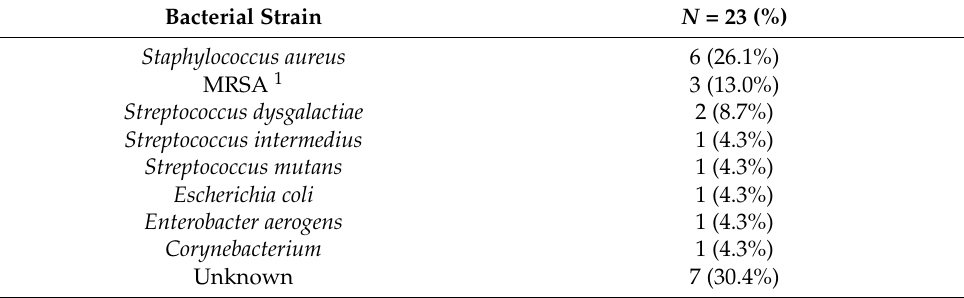
Table 2. Causative